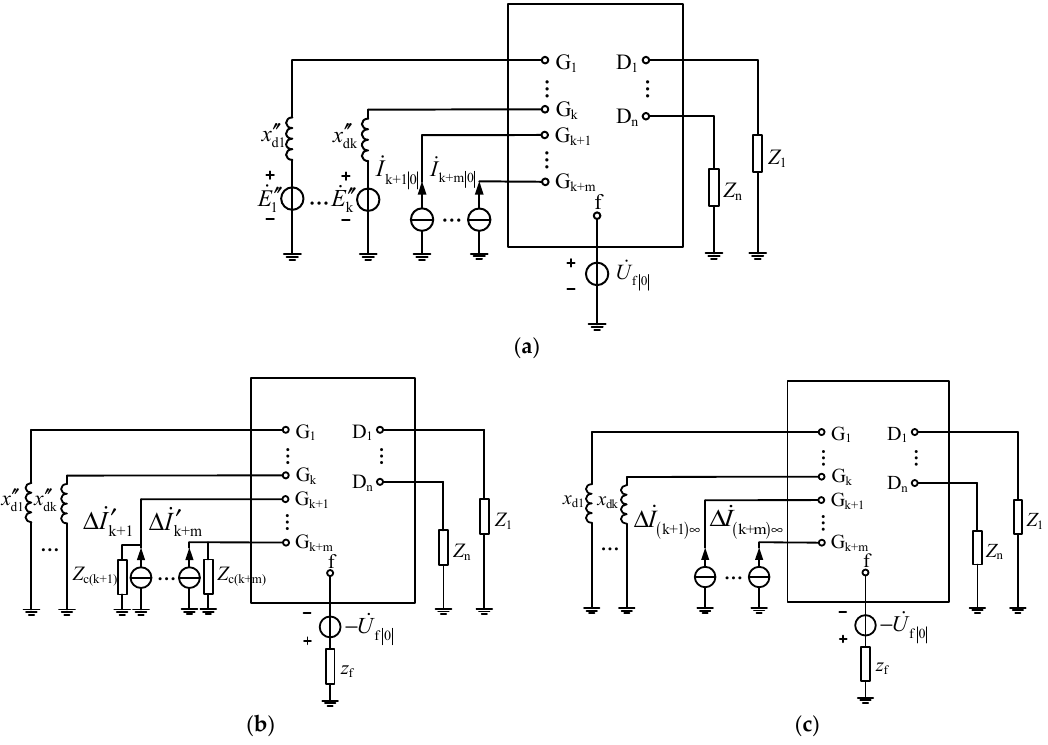
Figure 10. Normal component network and fault component network of AC components during a fault. ( a ) normal component network; ( b ) fault component network during transient period; ( c ) fault component network during steady